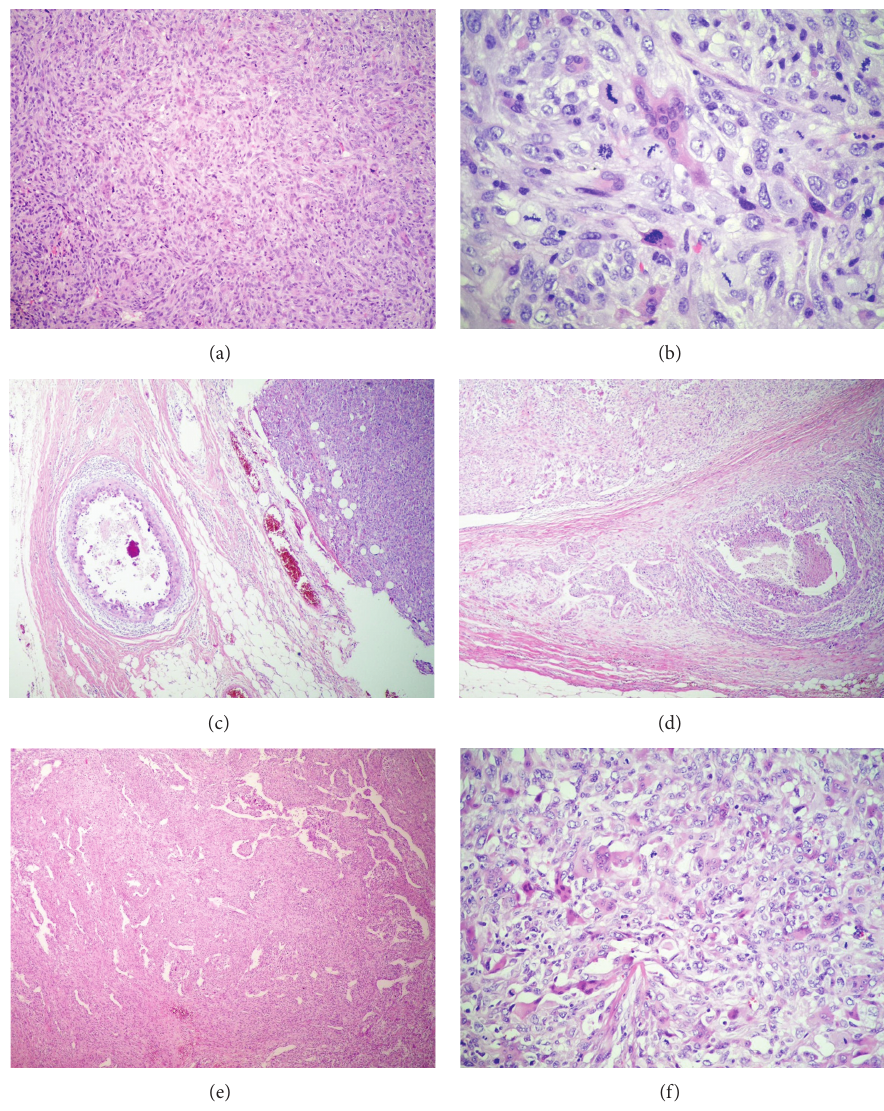
Figure 2: (a) Histological findings of malignant neoplasia of the oral cavity, showing atypical spindle cells with a storiform arrangement (H&E stain, × 40). (b) Areas with osteoclast-like cells (H&E stain, × 400). (c) Histological findings of metaplastic breast carcinoma with carcinoma in situ area beside the sarcomatous component (H&E, × 100). (d) Invasive ductal carcinoma (H&E, × 40). (e) Sarcomatoid pattern with hemangiopericytic area (H&E, × 40). (f) Sarcomatoid component with osteoclast-like cells (H&E, ×